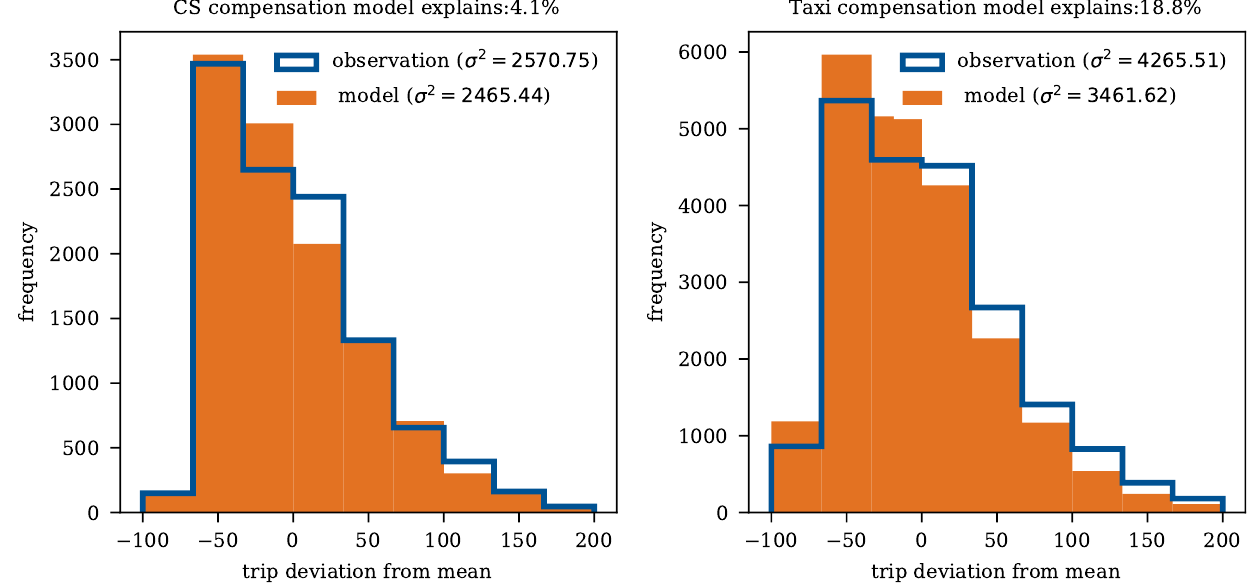
Figure 10. Explained Demand Variance due to